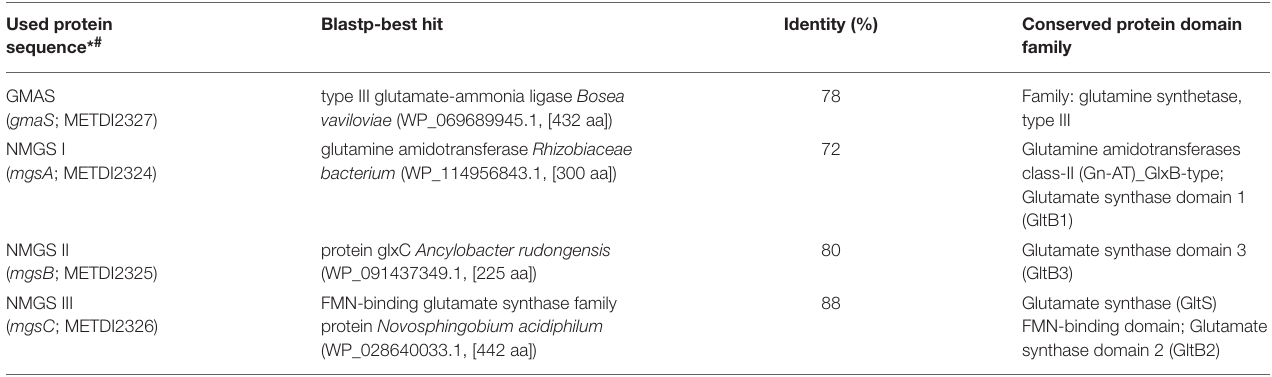
TABLE 3 | Protein-protein sequence